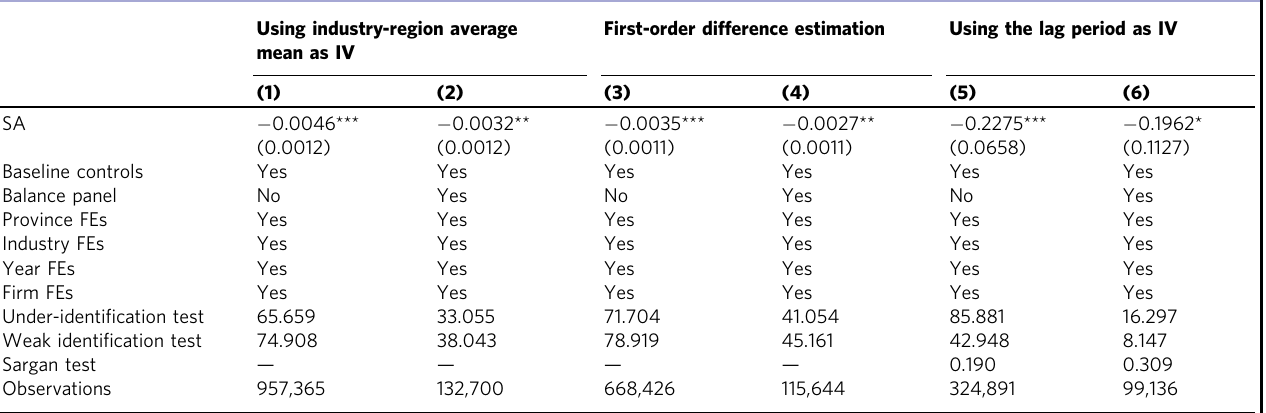
Table 5 Endogeneity test.